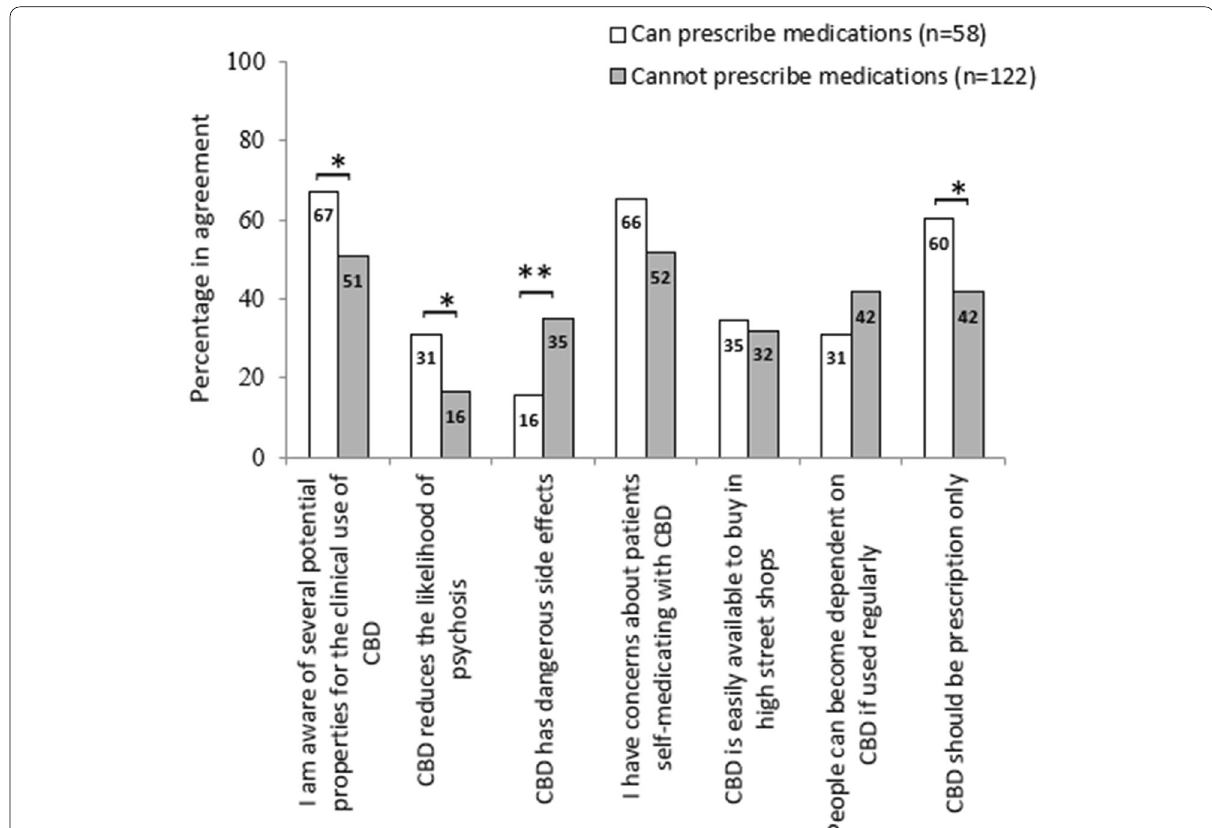
Fig. 3 Staff attitudes toward the medical use of cannabidiol, by ability to prescribe (percentage responding either ‘agree’ or ‘strongly agree’). Data labels represent percentages; differences are on chi-square testing; * p < 0.05, ** p <